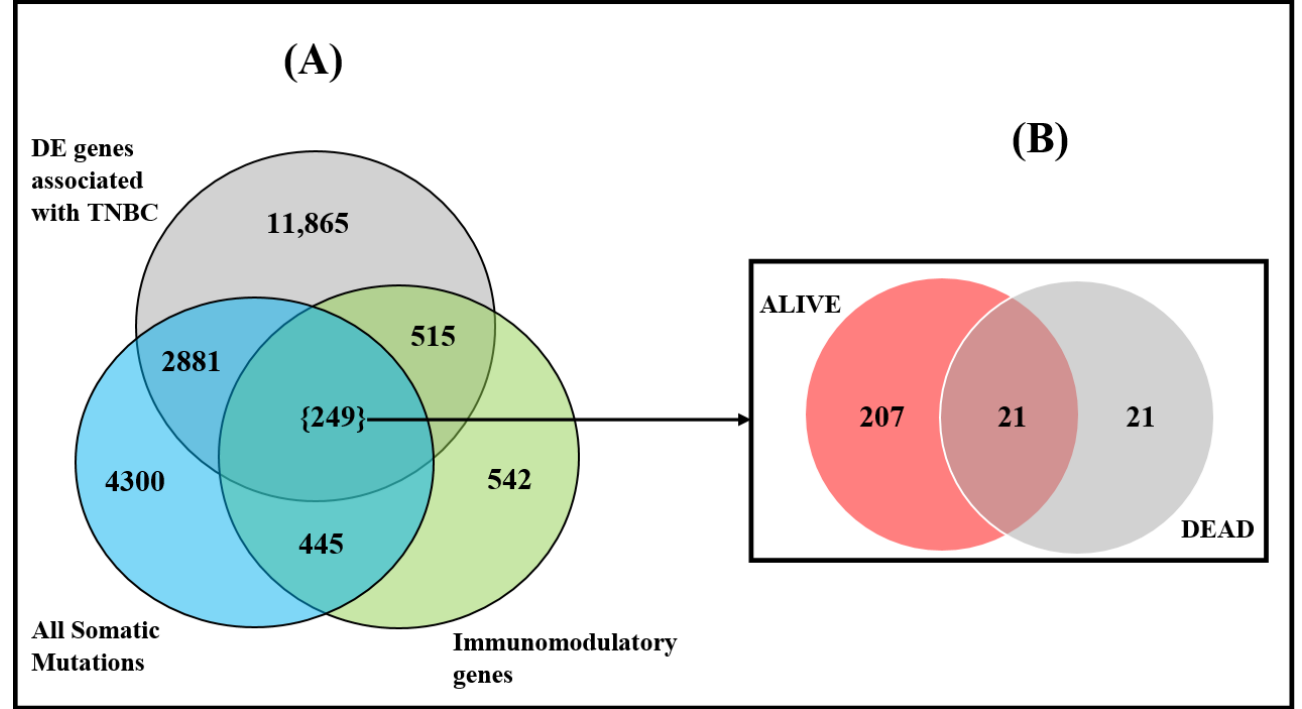
Figure 3. Distribution of somatic mutated and immune-modulated genes transcriptionally associated with TNBC ( A ), and stratified based on clinical outcome ( B ). Table 4. Somatic mutated immune-modulated genes associated with TNBC in the deceased